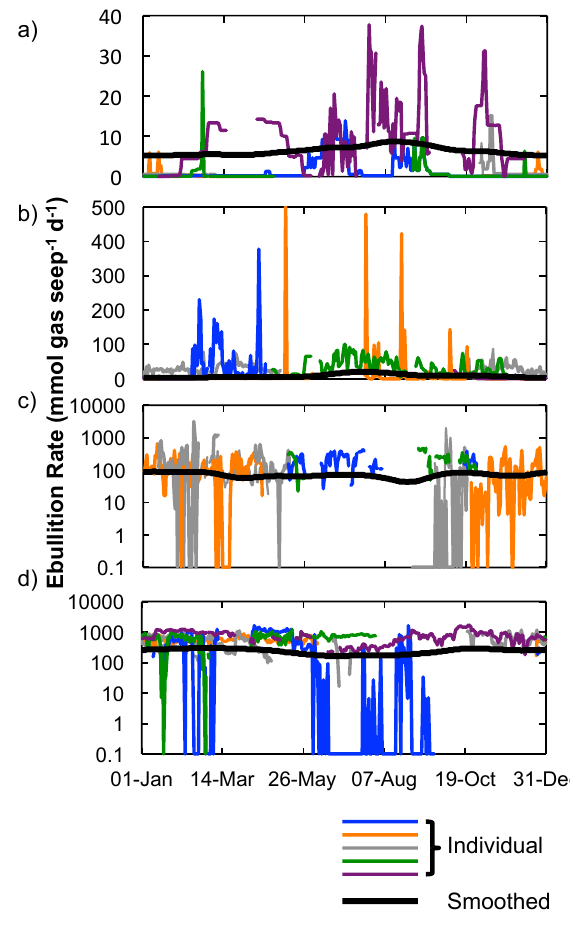
Figure 3. Time-smoothed daily ebullition rates, and rates for indi- vidually measured seeps as applied in the model, for A-, B-, C-, and Hotspot-type seeps (panels a , b , c , d ). Note the difference in scales on y axes, including the log scale in panels c and d